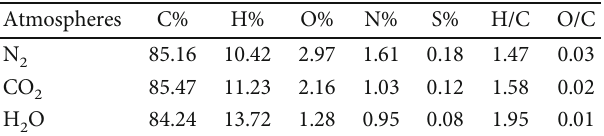
Table 4: Elemental analysis of pyrolysis oil in di ff erent atmospheres.